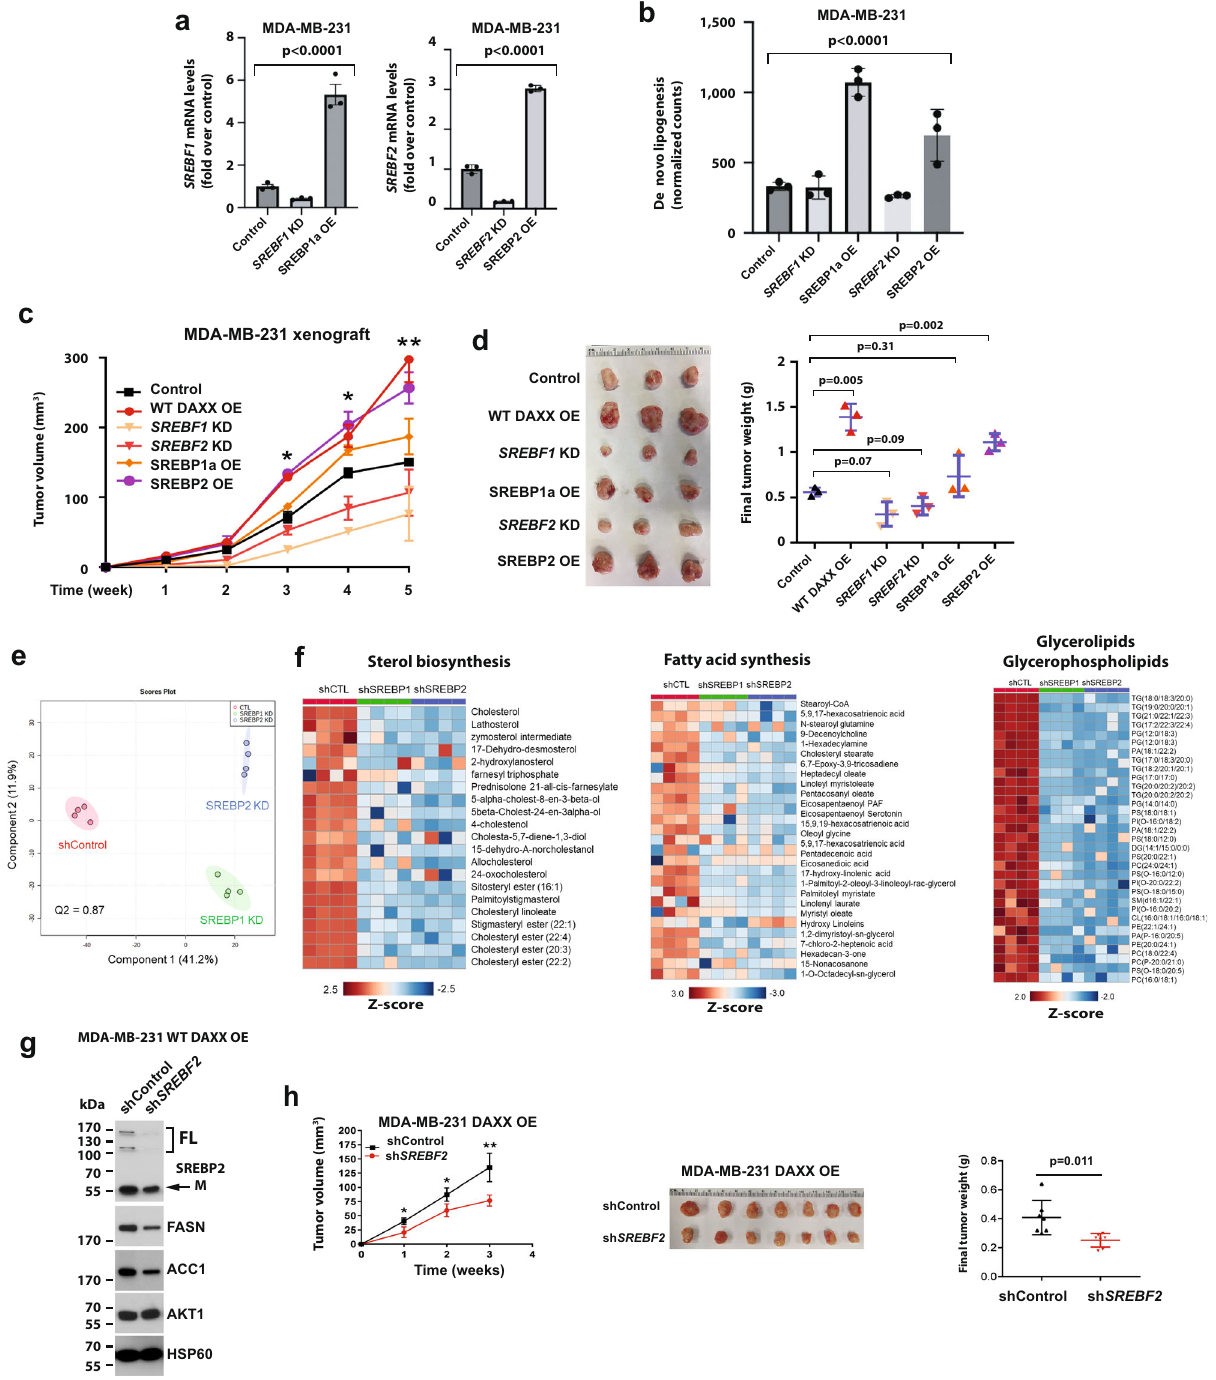
Fig.6|SREBP1,SREBP2,andtheDAXX – SREBPaxispromotelipidsynthesisand tumor growth. a Cells derived from MDA-MB-231 cell line with a vector for a control,an SREBF1 shRNA(KD),orSREBP1a(mature)cDNA,an SREBF2 shRNA(KD), or SREBP2 (mature) cDNAweresubjectedto RT-qPCRfor assessing the expression of SREBF1 and SREBF2 . b The panel of cell lines in ( a ) were tested for de novo lipogenesisassays using [1- 14 C] acetate. In ( a , b ),the P values werecalculated using ordinary one-way ANOVA ( n =3 biologically independent samples). c , d The panel of MDA-MB-231-derived cell line shown in ( a) were xenografted into mammary fat padsof female NSGmice ( n =3tumor-bearing mice).Tumor volumeswereplotted against time ( c ). The images of dissected tumors are shown, and the fi nal tumor weights are plotted ( d ). e PCA of lipidomes in shControl (shCTL), shSREBP1 and